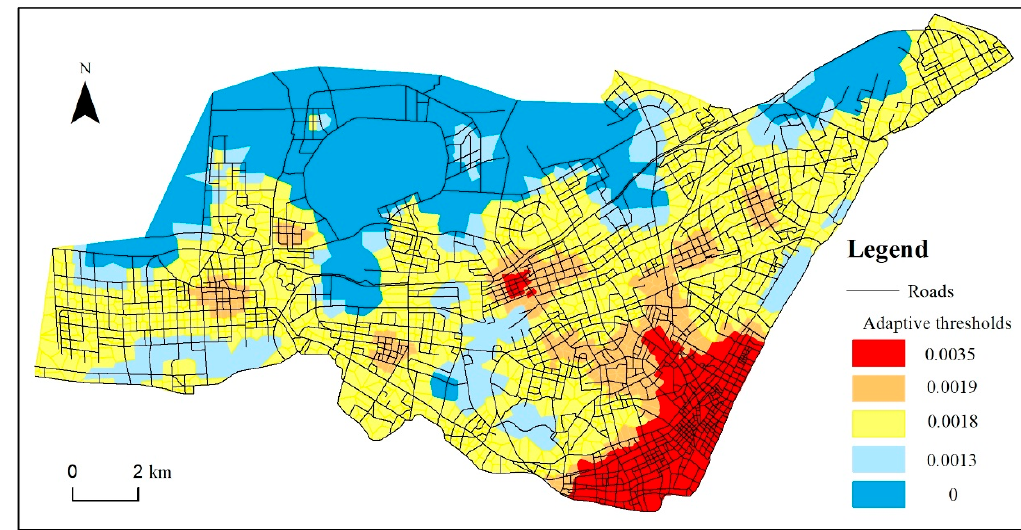
Figure 4. Road density partition result and the preset thresholds of the clustered regions. Denser areas are constrained by more stringent thresholds.